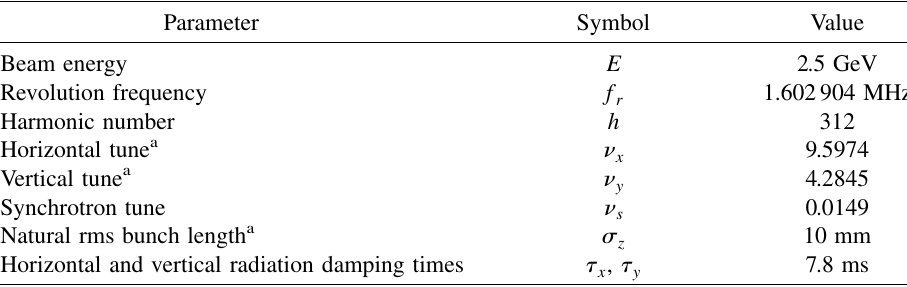
TABLE I. Parameters of the PF storage ring under the horizontal quadrupolar-tune